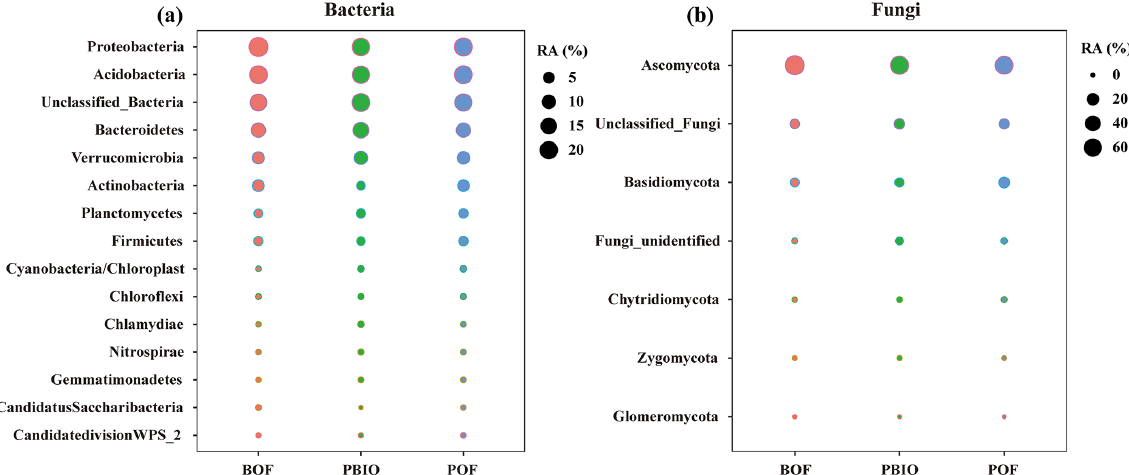
Figure 2. Bubble chart of bacterial (a) and fungal (b) phyla in BOF, POF and PBIO treatments. BOF – banana continuously cropped with OF application; POF – banana–pineapple rotation with OF application in the banana season; and PBIO – ,banana–pineapple rotation with BIO application in the banana season; values represent the average abundance across the nine replicate libraries for soil samples collected from each treatment. Table 1. Bacterial and fungal α -diversity indexes of the three treatments. BOF – banana continuously cropped with OF application; POF – banana–pineapple rotation with OF application in the banana season; PBIO – banana–pineapple rotation with BIO application in the banana season; values represent the average index of nine replicates. Means followed by different letters for a given factor are significantly different ( p < 0 . 05; Duncan